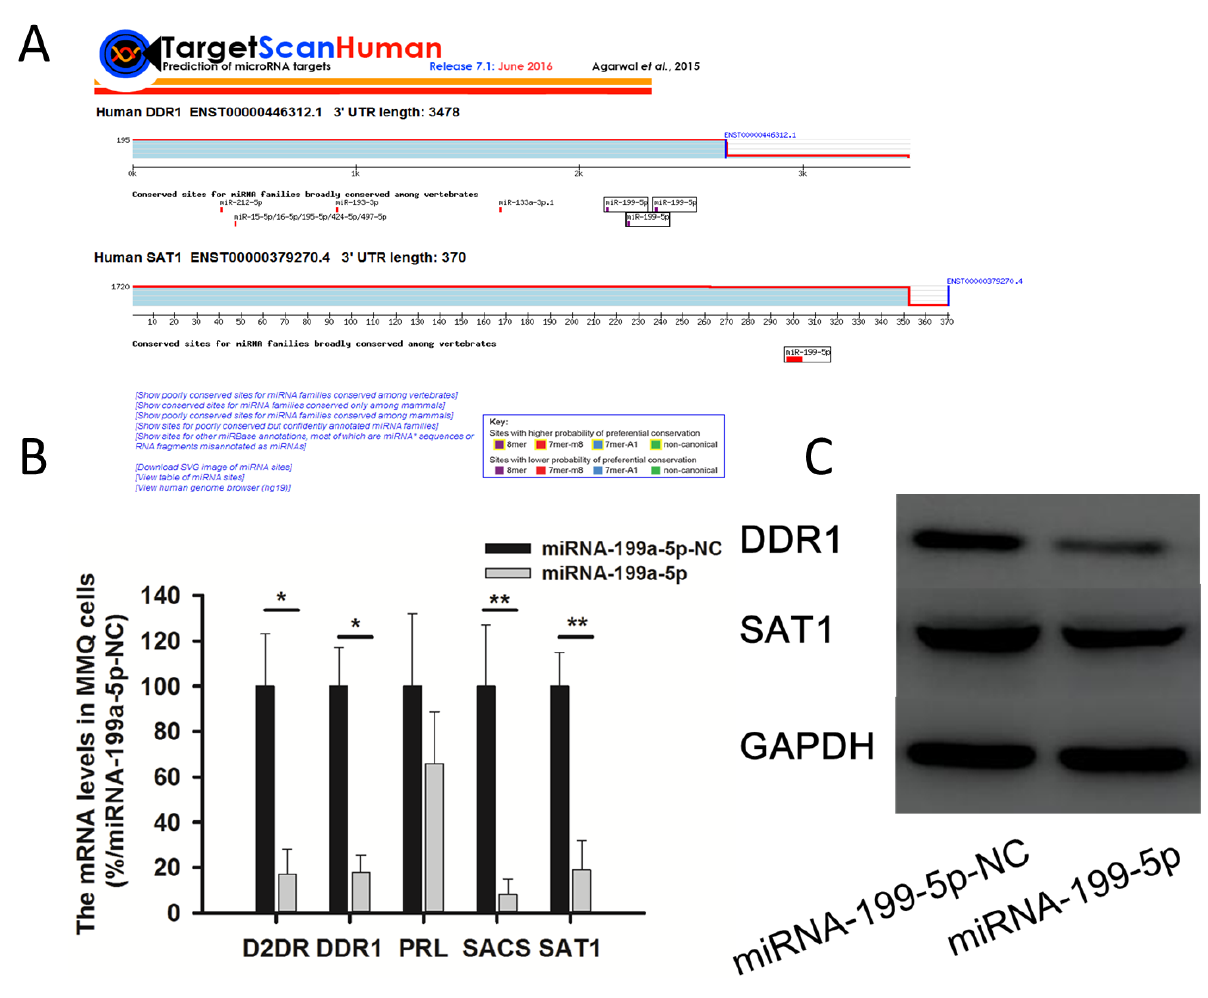
Figure 4: miRNA-199a-5p controlled the expression of DDR1 and SAT1 in MMQ cells. A: miRNA-199a-5p targeted the 3ʹUTR of DDR1 and SAT1. B: RT-qPCR data from target genes of miRNA-199a-5p and genes relate to DAs treatment. C: Western blots of DDR1 and SAT1. * compared to miRNA-199a-5p-NC